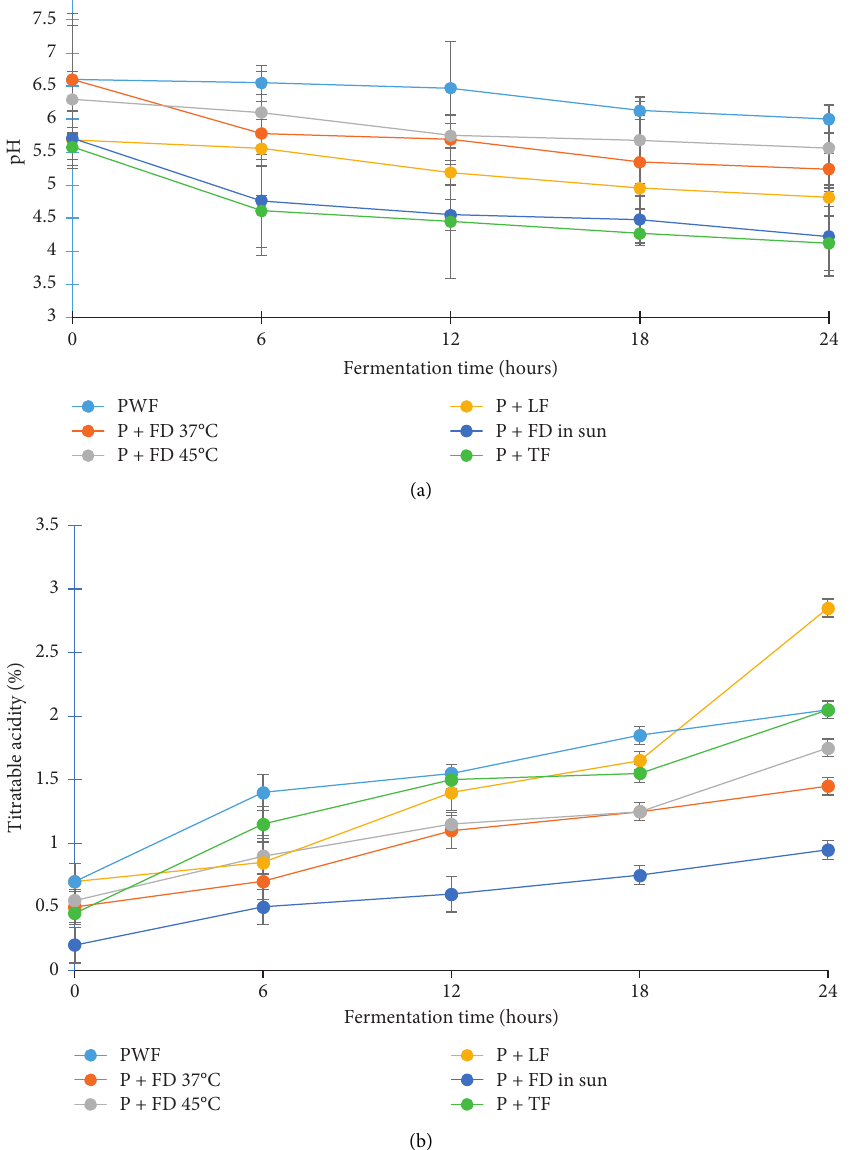
Figure 3: pH (a) and titratable acidity (b) of fermenting cassava pastes inoculated with the ferments obtained after drying. PwF: fermented paste without ferment; P +FD 37 ° C: paste inoculated with the ferment dried at 37 ° C; P +FD 45 ° C: paste inoculated with the ferment dried at 45 ° C; P + FD in the sun: paste inoculated with the ferment dried in the sun; P +FL: paste inoculated with Lyophilized ferment, P +TF: paste inoculated with traditional